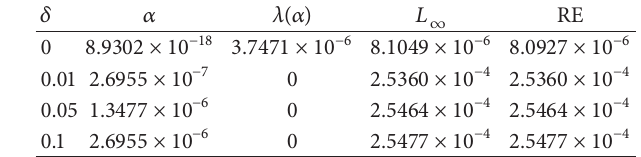
Figure 1: Flow chart for the calculation of regularization parameter based on GA.